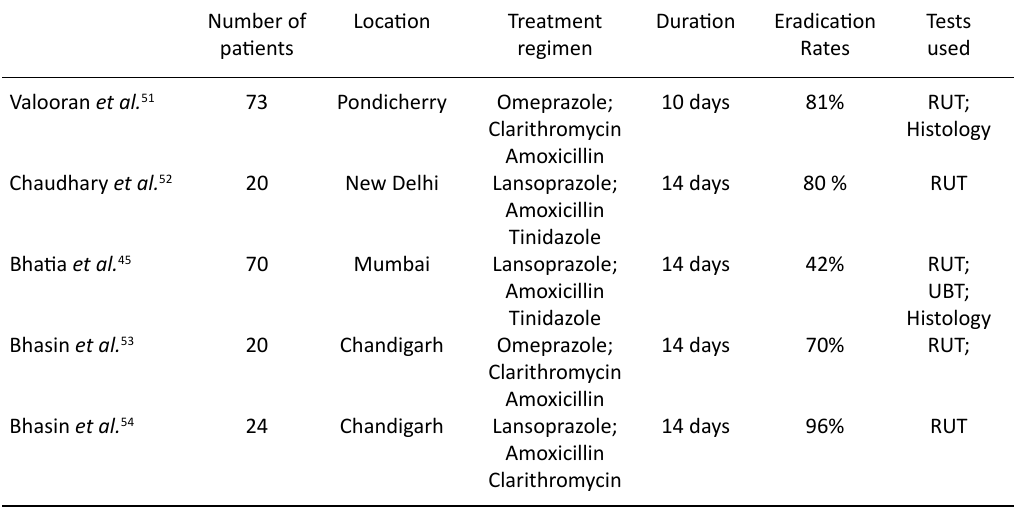
Table 2. Eradication Rates of H. pylori in India Number of Location Treatment Duration Eradication patients regimen Rates